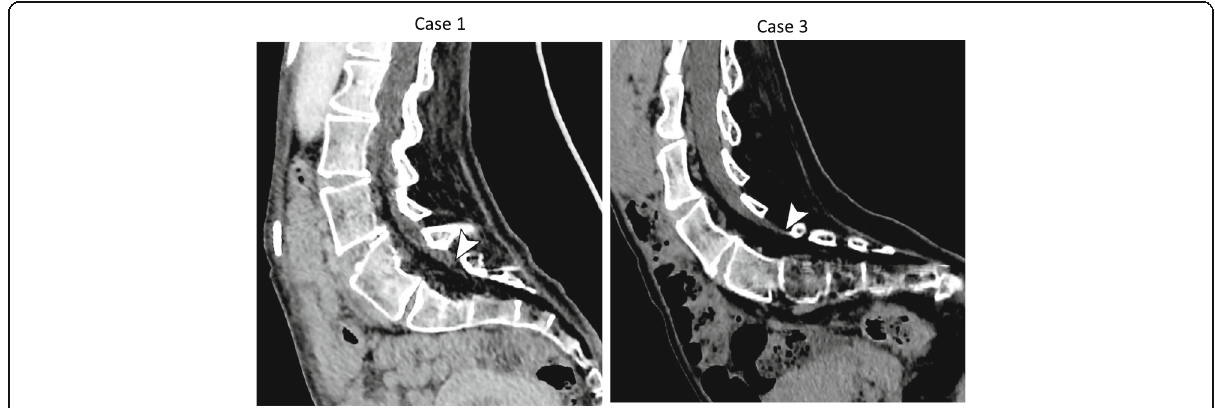
Fig. 2 Curved multiplanar reconstructed images in 2 cases (cases 1 and 3). Arrowheads indicate the lower end of the dural